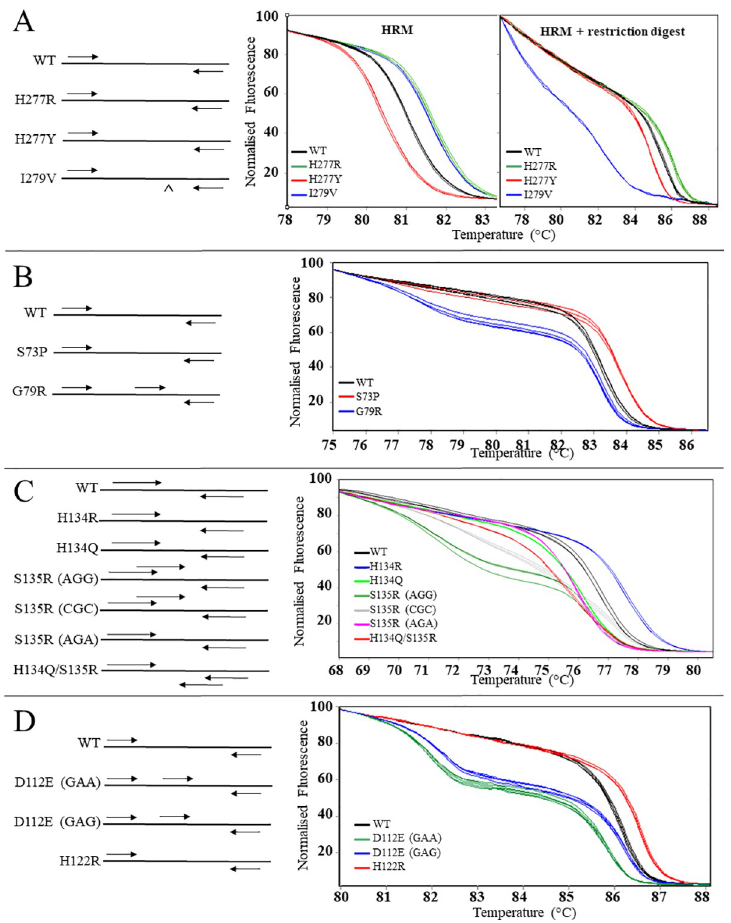
Fig 3. High resolution melt analysis for allele detection in the succinate dehydrogenase ( Sdh ) genes of Didymella tanaceti . Left hand side of figure indicates primer binding regions and right-hand side shows normalised fluorescence for each of the known substitutions and wild-type in (A) SdhB codons 277 and 279; (B) SdhC codons 73 and 79; (C) SdhC codons 134 and 135 and (D) SdhD codons 112 and 122. On left hand side, black lines indicate the gene and arrows indicate the annealing position of primers (not to scale).